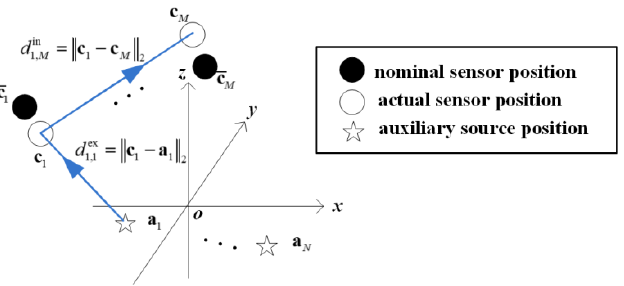
Figure 1. The arrangement of the distributed sensor network assisted by N auxiliary sources. Internal Measurement : Assuming all range measurements have been extracted from the received signals by sensors after a preprocessing algorithm, the internal range measurement from sensor l to sensor k , due to the line-of-sight propagation, is expressed by = d in + w in r in , l = 1, · · · , k − 1, k + 1, · · · , M (1) k , l k , l k , l = (cid:107) c − c (cid:107) where d in is the true internal propagation range and w in k l 2 k , l ment noise. In practice, under the noise model in [38,39], the internal noise w in